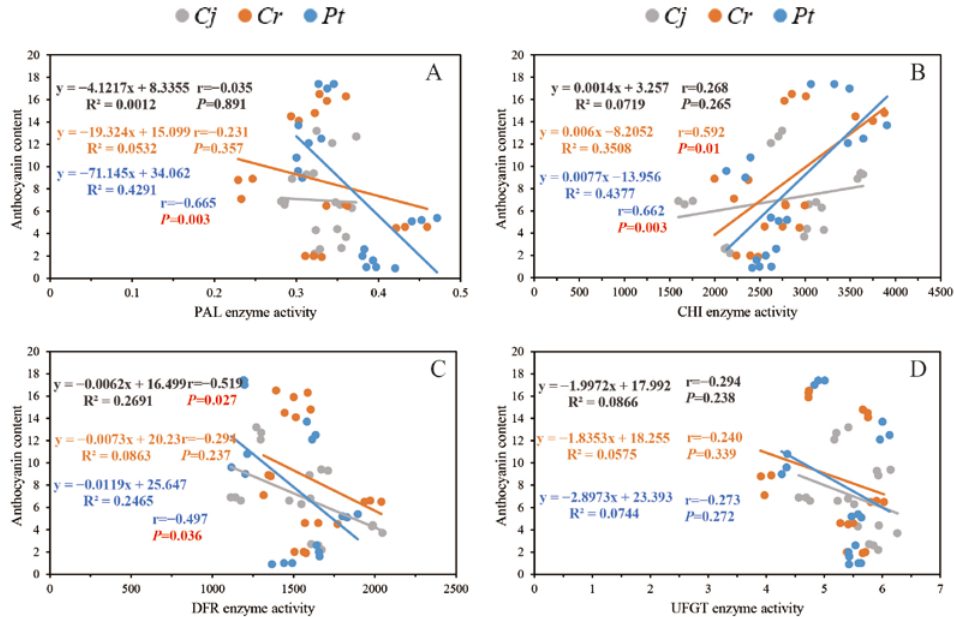
Figure 9. The correlations between anthocyanin content and the activity of several enzymes that catalyze anthocyanin synthesis: ( A ) PAL enzyme; ( B ) CHI enzyme; ( C ) DFR enzyme; and ( D ) UFGT enzyme.